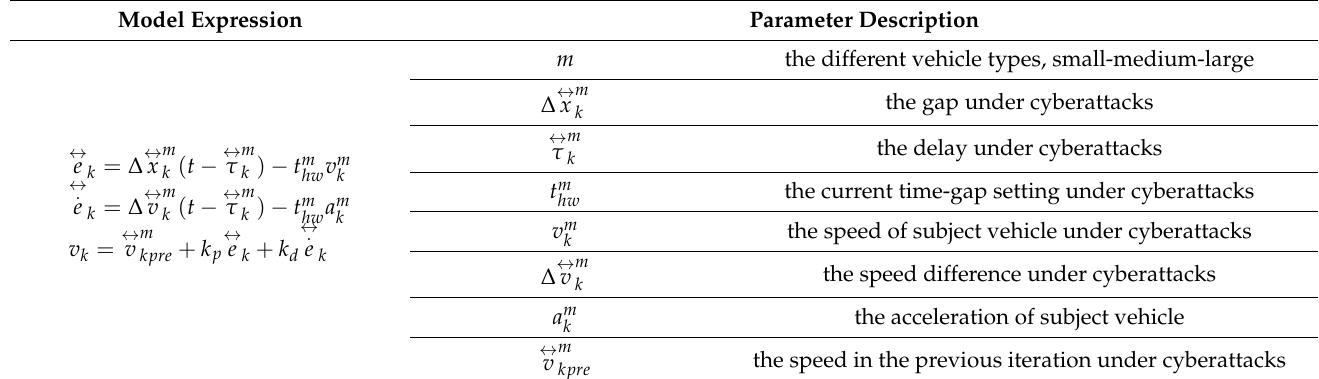
Table A2. Extended PATH’s CACC car-following model considering mixed flow and cyberattacks.